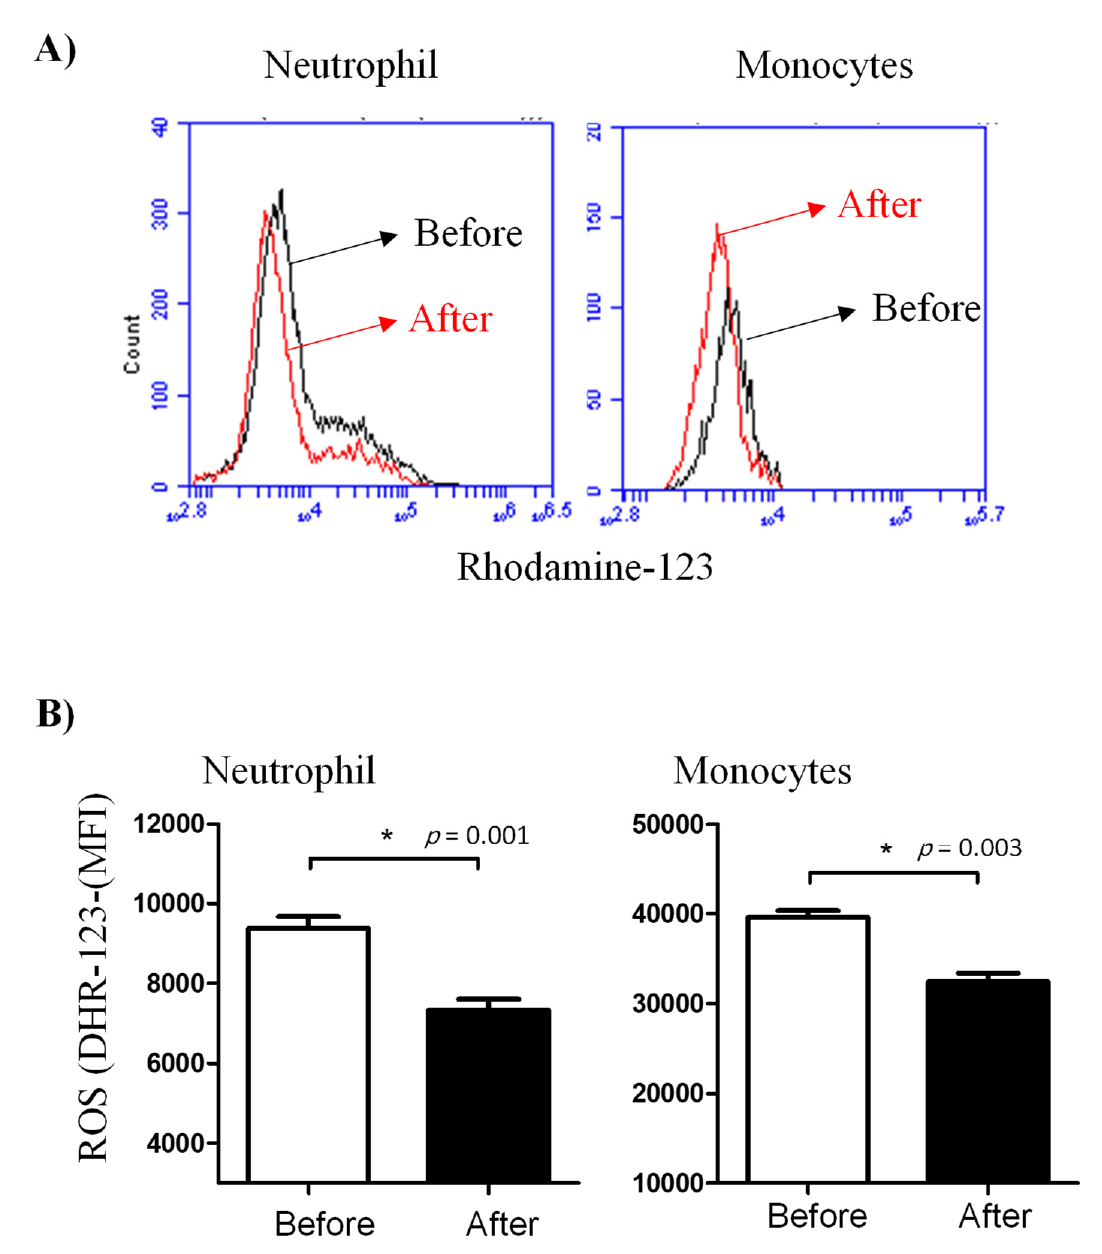
Figure 5. Ex vivo measurement of the ROS generation activity of camel leukocytes by flow cytometry. Leukocytes were isolated from the blood before and after administration of camels with lornoxicam and the separated cells were stimulated with heat-killed bacteria. ( A ) The ROS activity of camel leukocytes was estimated by increased green fluorescence due to the generation of rhodamine-123. ( B ) The MFI (mean ± SEM) of gated cells was presented for samples collected before and after treatment with lornoxicam. Differences between the means were considered significant (*) if p < 0.05.